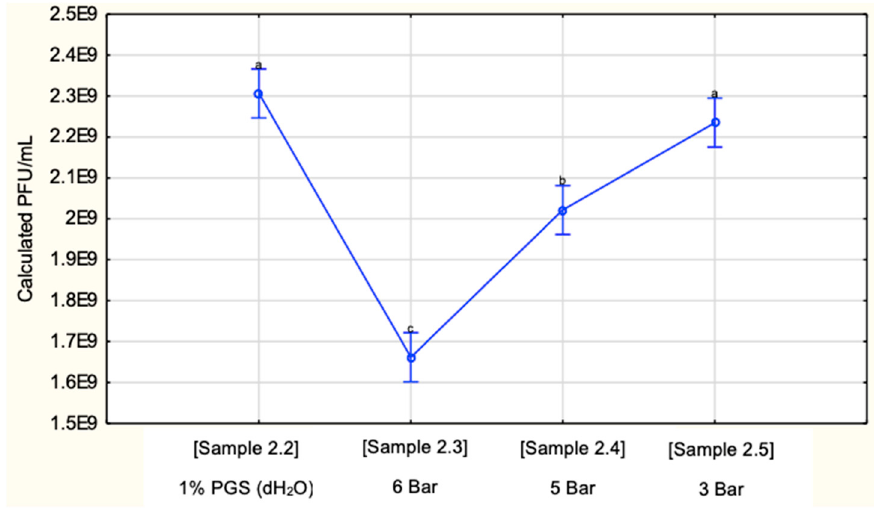
Figure 5. Calculated PFU/mL of 1% PGS (dH 2 O) before being sprayed (sample 2.2) through the mesh (200) and nozzle (530 μ m) at pressures of 6, 5 and 3 Bar (sample 2.3–2.5). There were no significant differences observed between samples 1.5 and 1.2, and 1.5